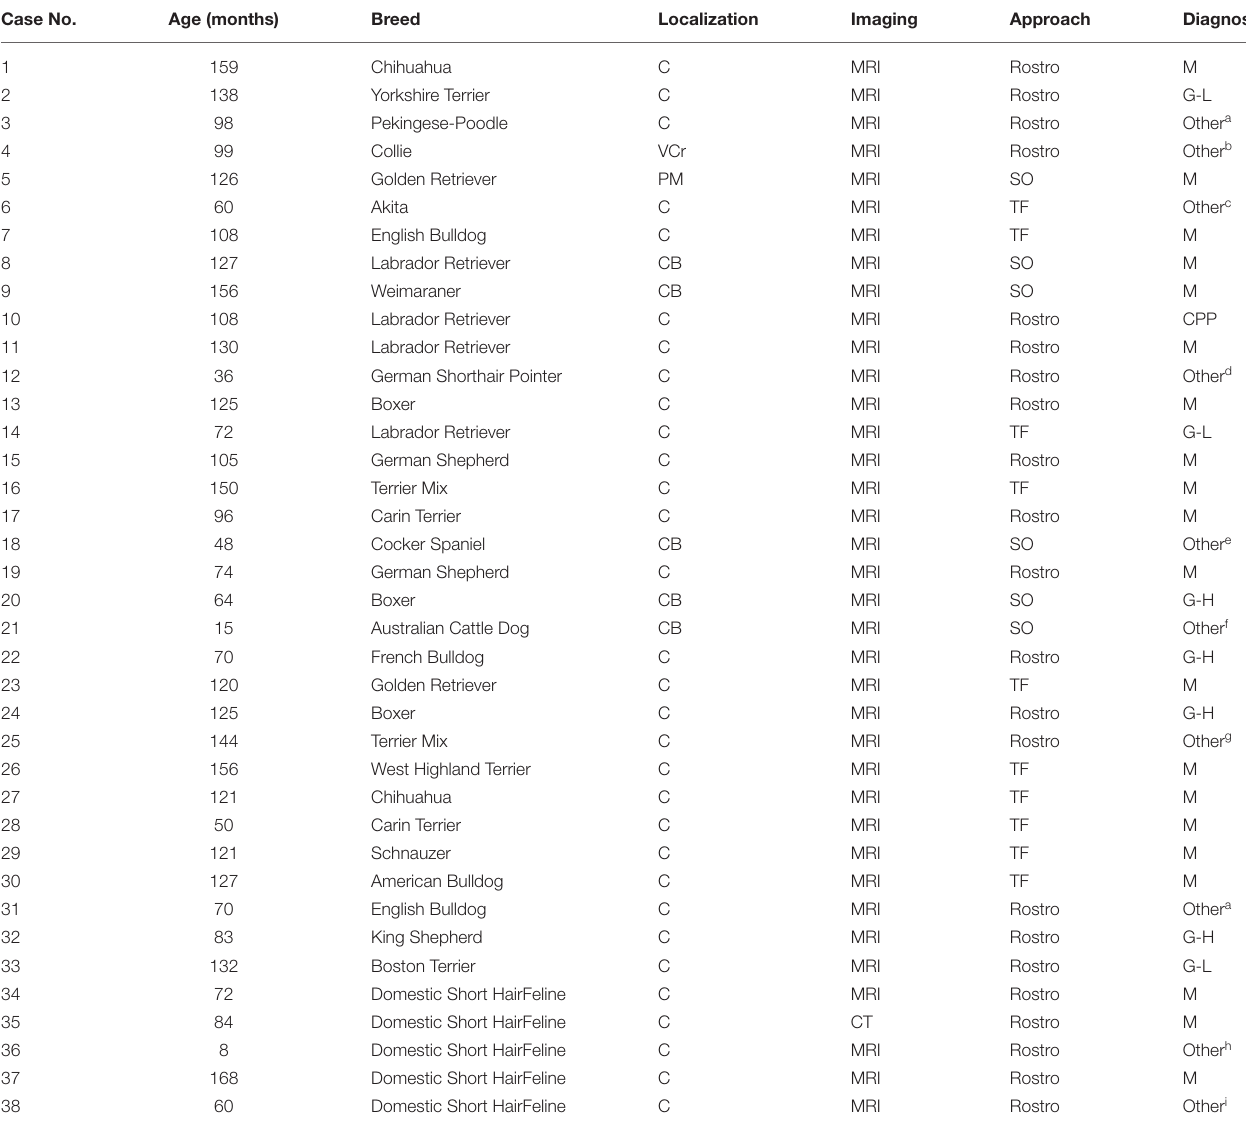
TABLE 1 | Summary of patients undergoing craniotomy/craniectomy and intraoperative ultrasound (2012–2019). Case